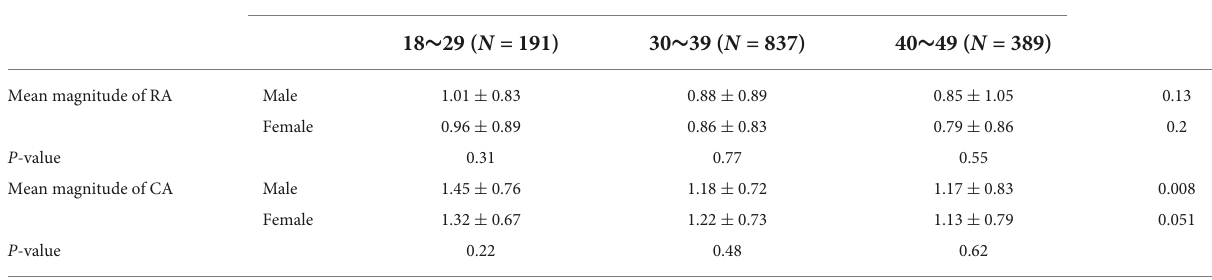
TABLE 2 Univariate comparison of the mean magnitude of refractive astigmatism and corneal astigmatism stratified by age and